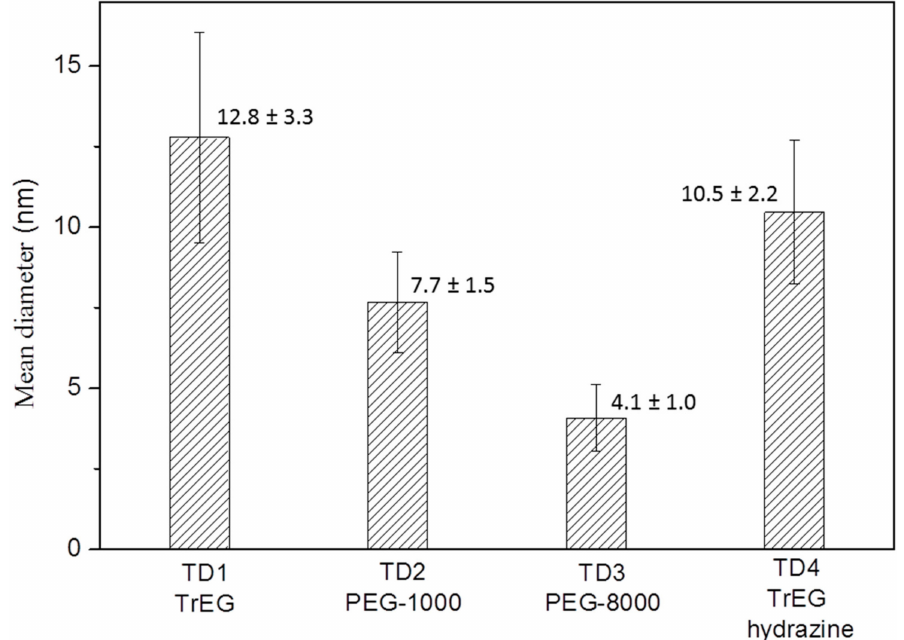
Figure 2. The mean diameter and its standard deviation of nanoparticles in samples